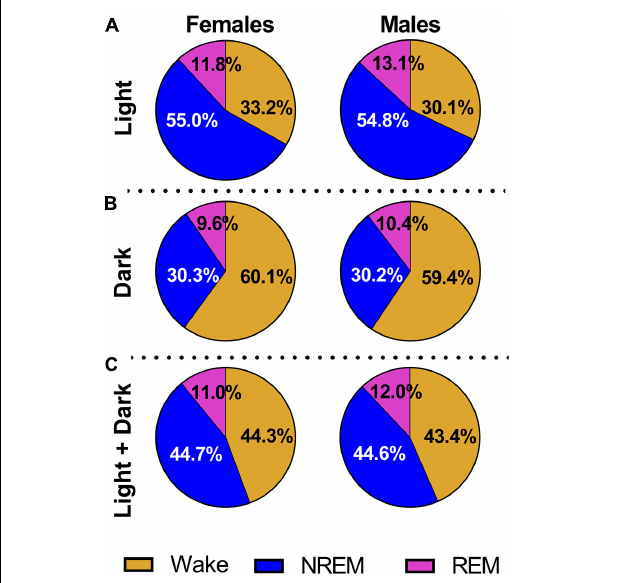
FIGURE 3 | All animals show normal sleep patterns regardless of treatment condition. (A) We combined Iso and Sham data to show that males and females displayed characteristic sleep distribution with a greater percentage of time spent asleep during the light cycle. Males also spent a greater percentage of time in REM sleep compared to females ( P = 0.013). (B) Combined Iso and Sham data also show that males and females exhibited normal sleep patterns during the dark cycle, with a greater percentage of time spent active and awake, but no sex differences were noted. (C) When light and dark cycles were combined, males spent a higher percentage of time in REM sleep compared to females ( P = 0.023).